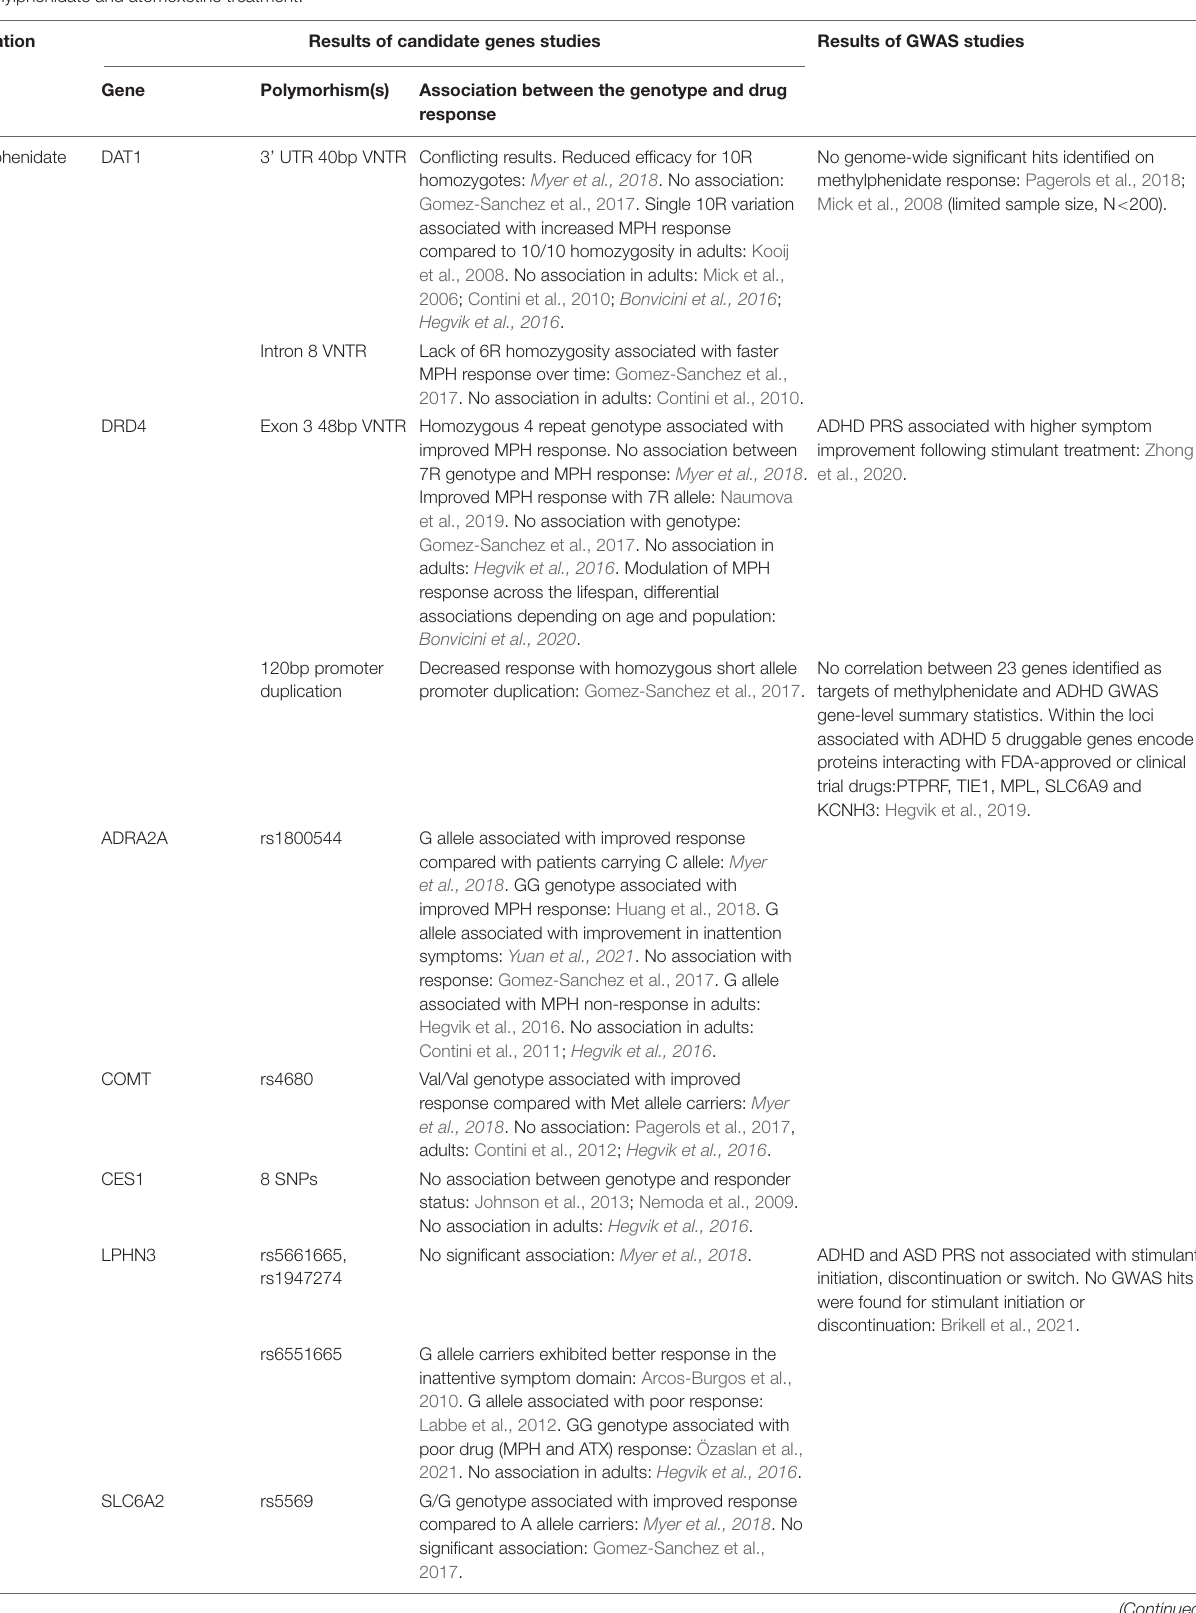
TABLE 2 | Summary of the pharmacogenetic studies assessing the most extensively investigated candidate genes and/or using genome-wide method in ADHD patients on methylphenidate and atomoxetine treatment. Medication Results of candidate genes